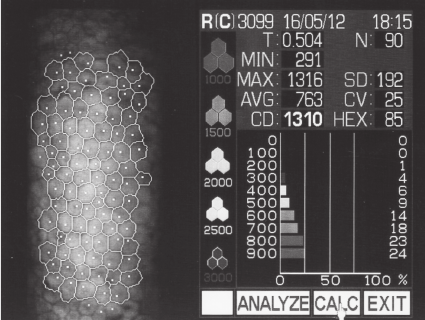
Figure 1: Specular photomicrograph from Topcon SP-3000P spec- ular microscope. N: number of cells; T: central corneal thickness; MIN, MAX, AVG: minimum, maximum, and average size of cell area; CD: cell density; SD: standard deviation, CV: coefficient of value; HEX: hexagonal cell ratio. Figure 2: Evaluation of cell density (ECD) in groups of patients